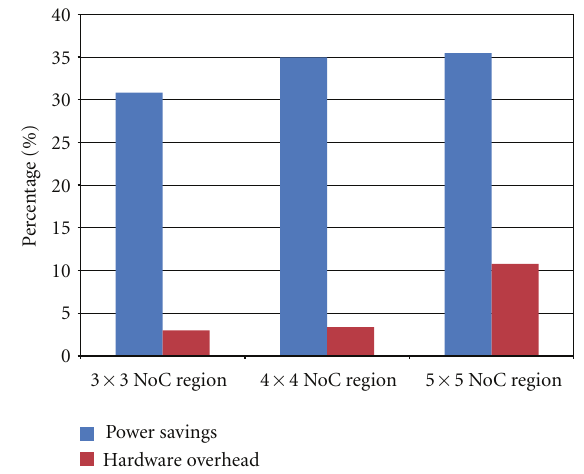
Figure 4: Power savings versus CMOS hardware overheads corre- sponding to various sizes of ANN monitoring regions in an